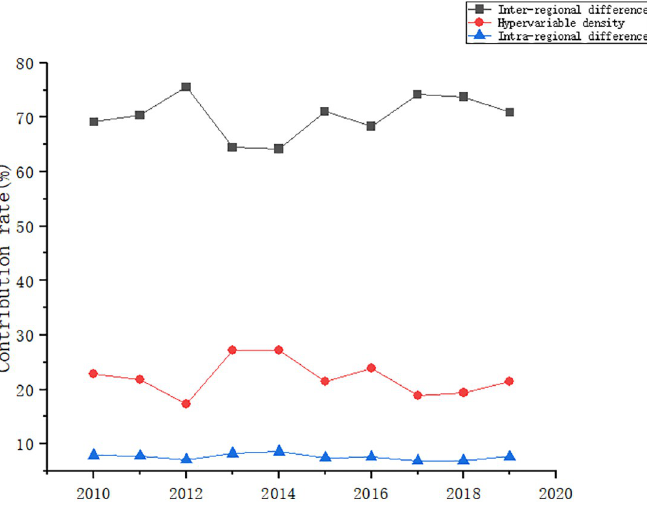
Fig 7. Differential contribution of coupling coordination degree of energy-economy-carbon emission